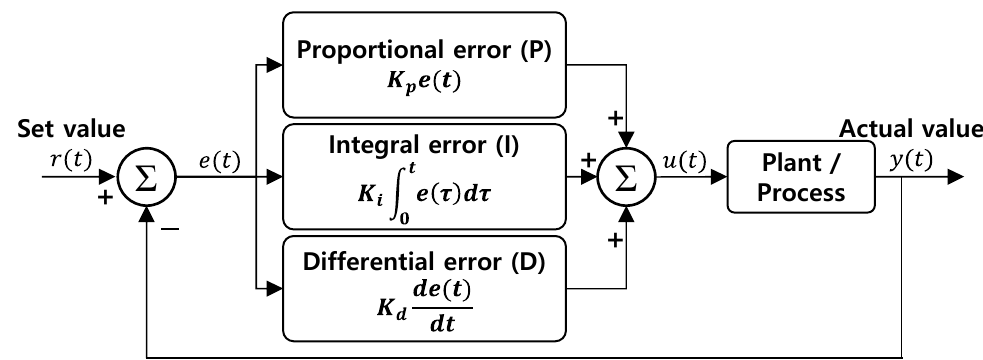
Figure 15. Block diagram of the PID controller principle.